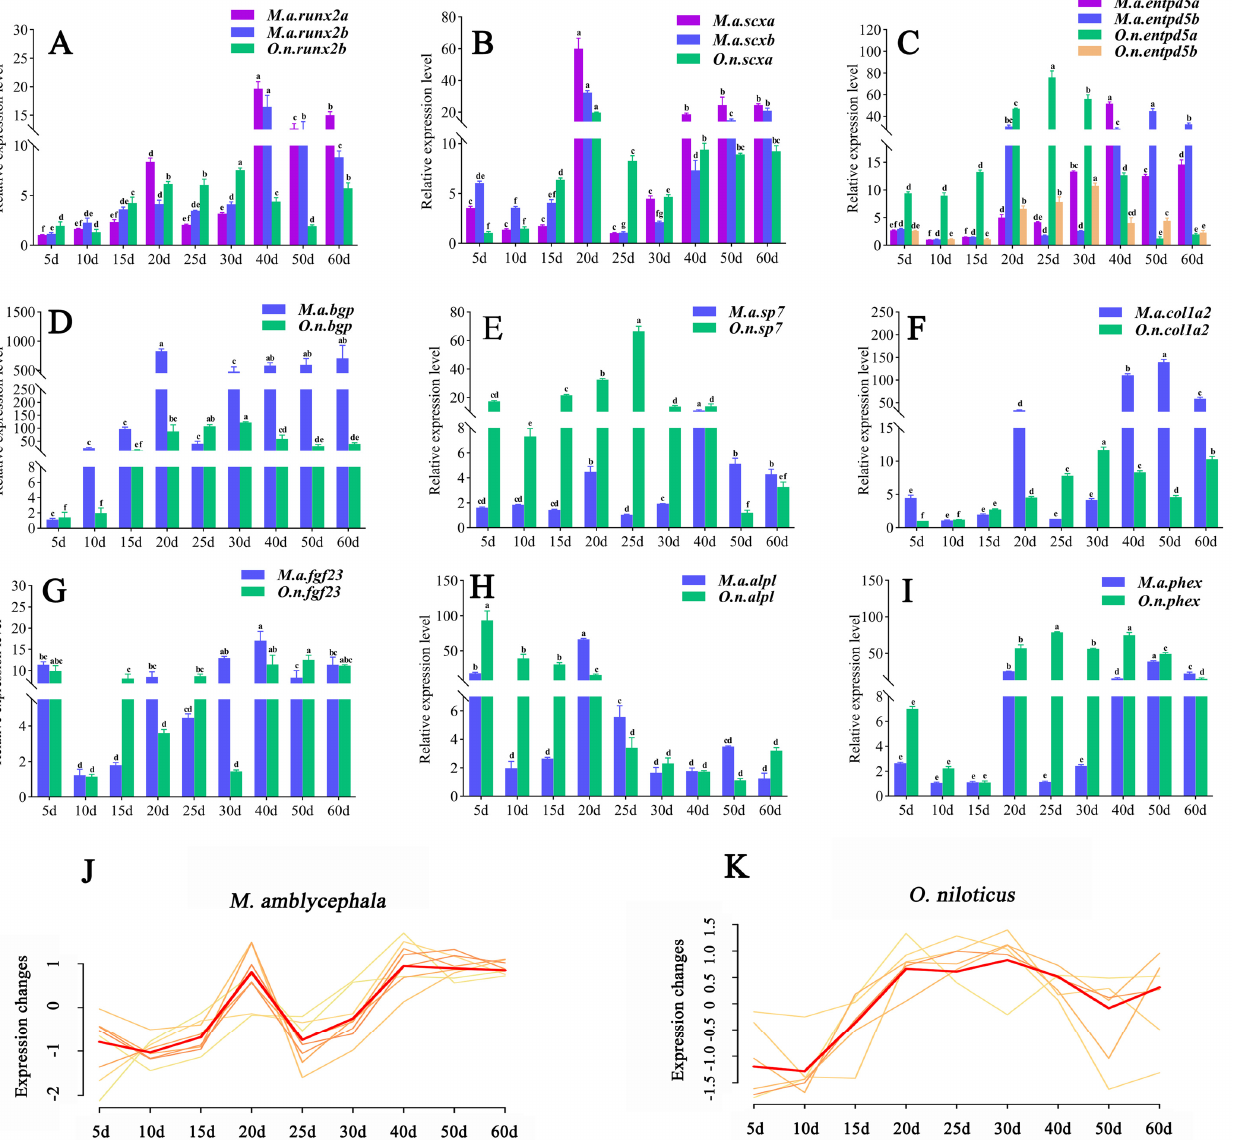
Figure 5. Expression analysis of the tested genes during IB development. ( A – I ) Relative expression levels of the tested genes ( runx2 , scx , entpd5, bgp , sp7 , col1a2 , fgf23 , alpl , phex ) at nine developmental stages in M. amblycephala and O. niloticus . The same letters above the columns for each gene mean no significant difference ( p > 0.05); ( J , K ) expression trends of scx , runx2 , entpd5 , bgp , and col1a2 in M. amblycephala and O. niloticus at nine developmental stages.